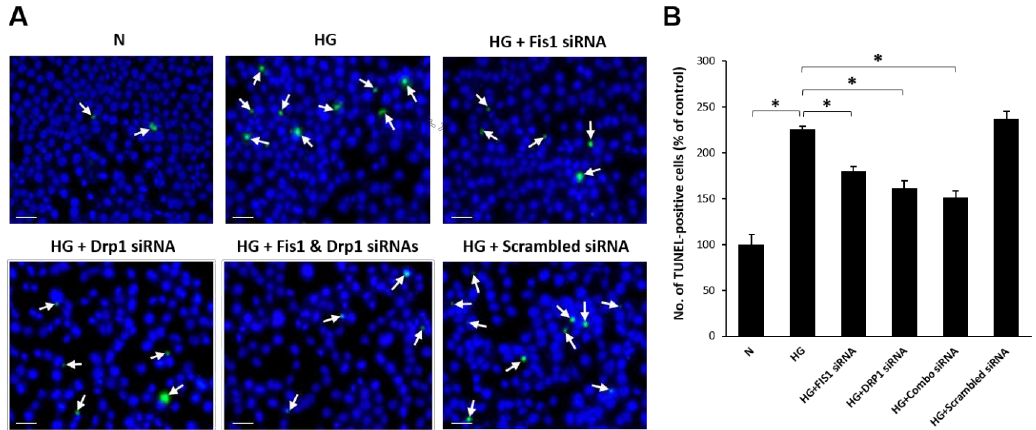
Figure 4. Reducing fission protects against HG-induced apoptosis. ( A ) Representative images of TUNEL-positive RRECs (white arrows) grown in normal medium, HG, HG transfected with DRP1 siRNA, HG transfected with FIS1 siRNA, HG transfected with DRP1 siRNA and FIS 1 siRNA, or HG transfected with scrambled siRNA. Scale bar = 50 μm. ( B ) Graphical illustration of cumulative data indicates that cells grown in HG medium or HG medium transfected with scrambled siRNA exhibit an increased number of TUNEL-positive cells. In parallel, downregulation of DRP1 and FIS1 fission genes significantly protects against HG-induced apoptotic cell death. Data are expressed as mean ± SD. * p < 0.05. n = 6.